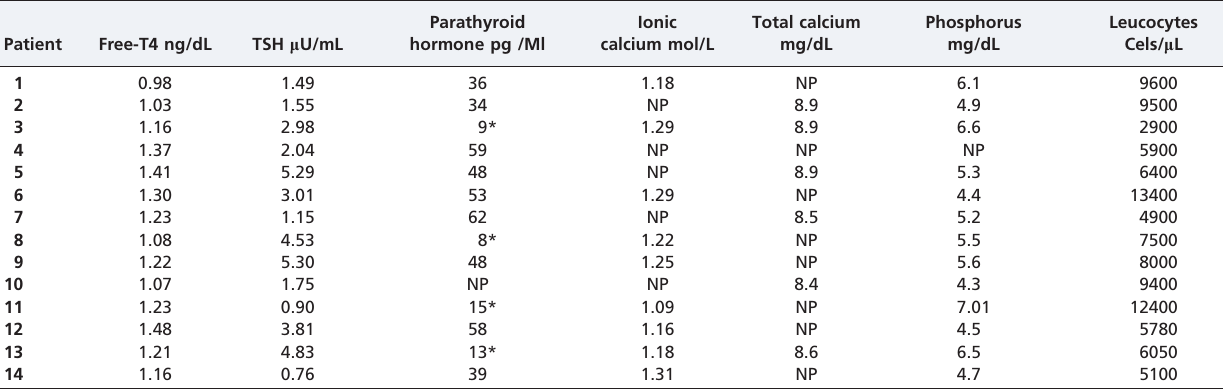
Table 2 - Laboratory data of 14 patients with